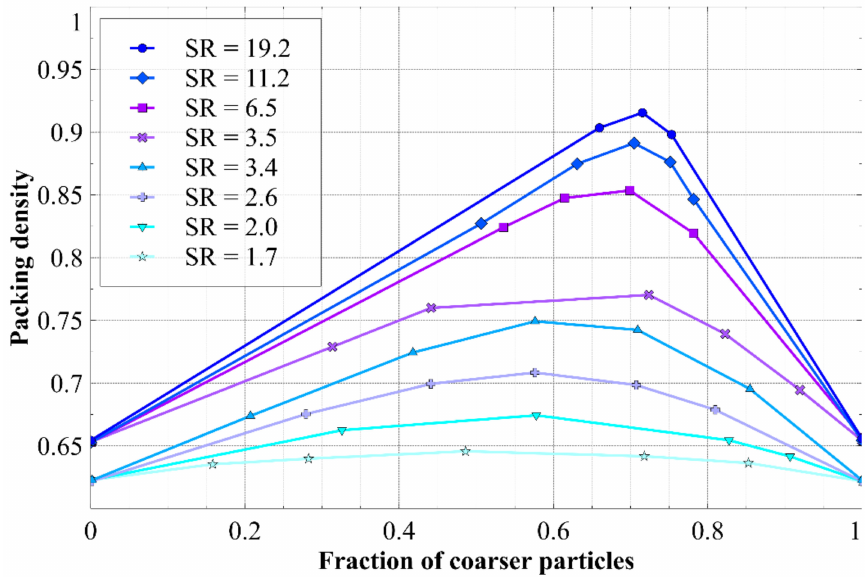
Figure 2. Packing density measured for binary mixtures of spherical particles, showing the effect of size ratio (SR) and the fraction of coarser particles. Data adapted from [25].